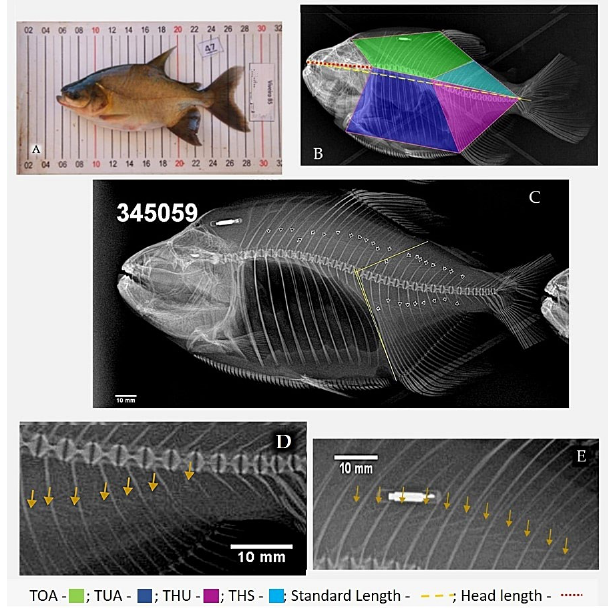
Figure 1. ( A )—Tambaqui specimen. ( B )—Measurement model of the areas corresponding to each zone: TOA—(green area); TUA—(dark blue area); THU—(pink area); THS—(light blue area); standard length (yellow dotted line) and head length (red dotted line). ( C )—Intermuscular position for counting. ( D )—Epipleural intermuscular bones. ( E )—Epineural intermuscular bones.